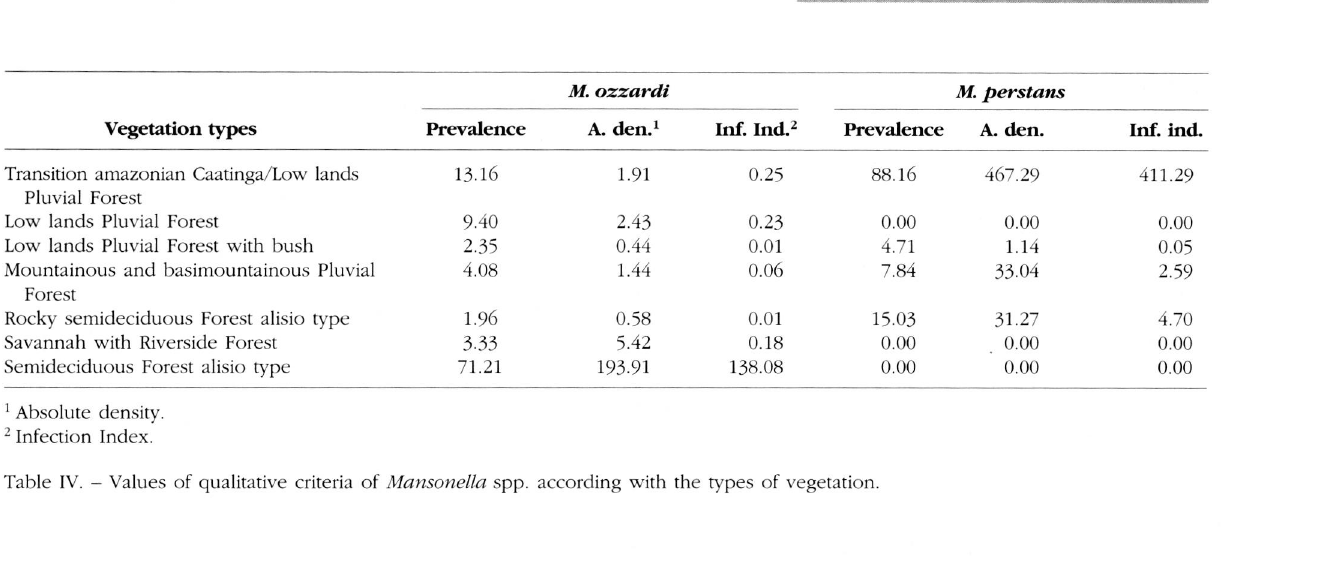
Table IV. — Values of qualitative criteria of Mansonella spp. according with the types of vegetation.